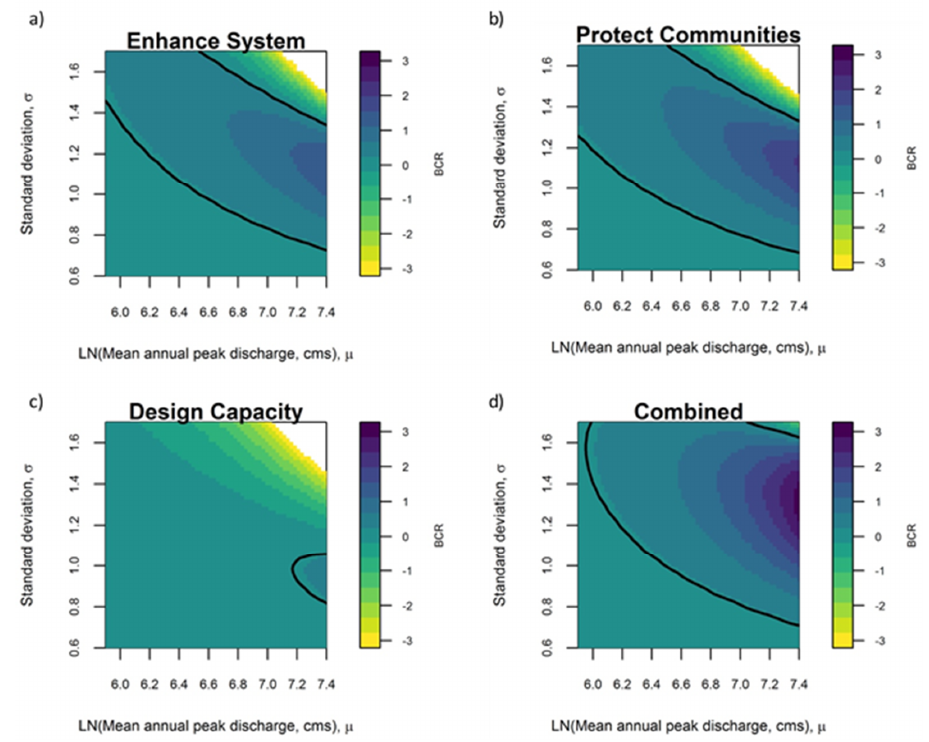
Figure 12. Benefit–cost ratio (BCR) response surfaces for each of the management strategies: ( a ) Design capacity, ( b ) protect communities, ( c ) enhance system, ( d ) combined. The strategy exceeds the cost-e ff ectiveness threshold for flood regimes between the black threshold lines where BCR = 0.2. BCR below − 3 are displayed in